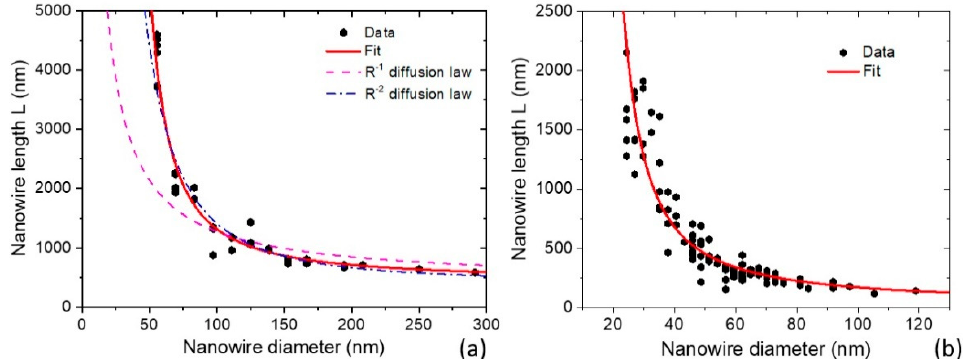
Figure 3. ( a ) Length–diameter dependence for Au-catalyzed GaAs NWs grown by MBE on unpatterned GaAs(111)B substrates [16]. The red line is the fit by the exponential model given by Equation (20) with ξ = 1. Dashed and dash–dotted lines show the fits obtained from the linear growth laws with R − 1 and R − 2 diffusion terms. ( b ) Length–diameter dependence for Au-catalyzed InP NWs grown by MBE on unpatterned InP(111)B substrates [41]. The line shows the fit by the exponential model given by Equation (20) with ξ = 0.446 .